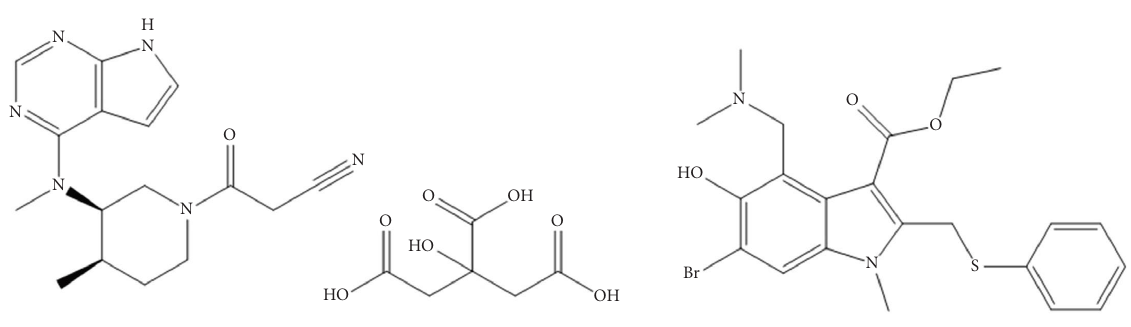
Figure 1: Chemical structures representing remdesivir, favipiravir, umifenovir, and tofacitinib